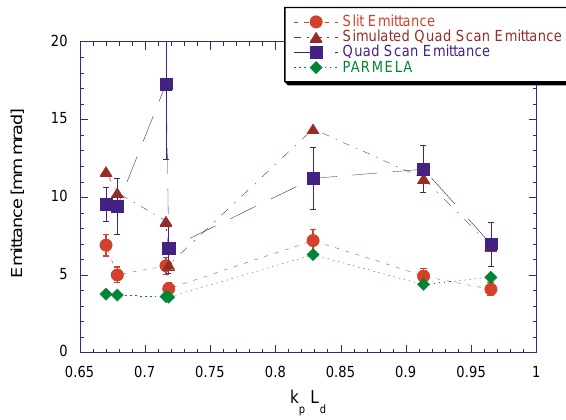
FIG. 8. (Color) Simulation of the quadrupole scan plotted with the PARMELA simulations and the measured emittance data.